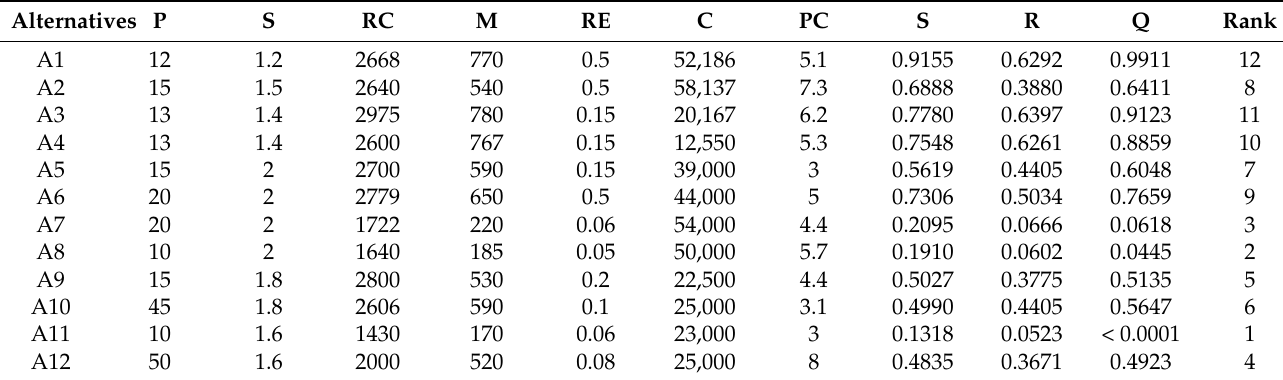
Table 12. Rank calculations using VIKOR.